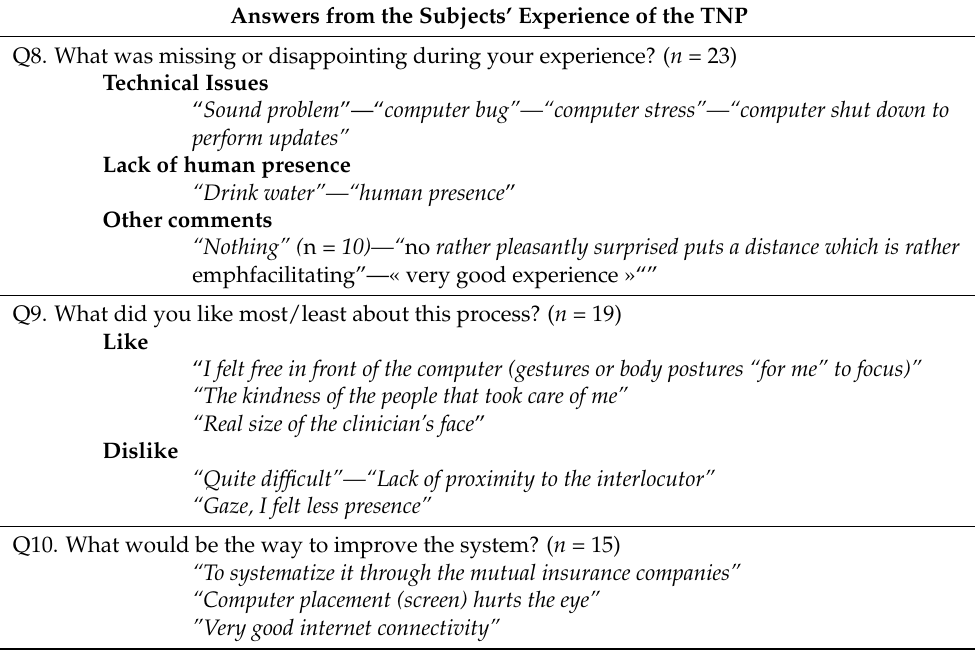
Table 6. Answers from the subjects’ experience of the TNP. (Translated from French to English). Answers from the Subjects’ Experience of the TNP Q8. What was missing or disappointing during your experience? ( n =